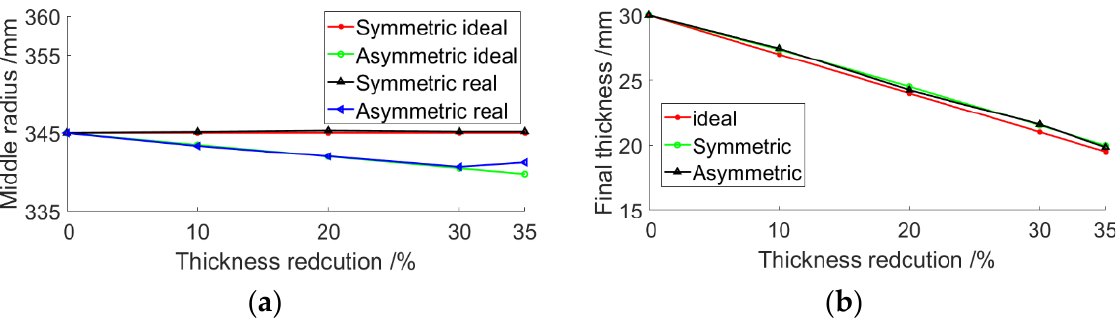
Figure 19. The thickness of the tube blank influence on the final tube shape: ( a ) Middle radius; ( b ) Thickness (ideal: ideal situation; real: real situation).